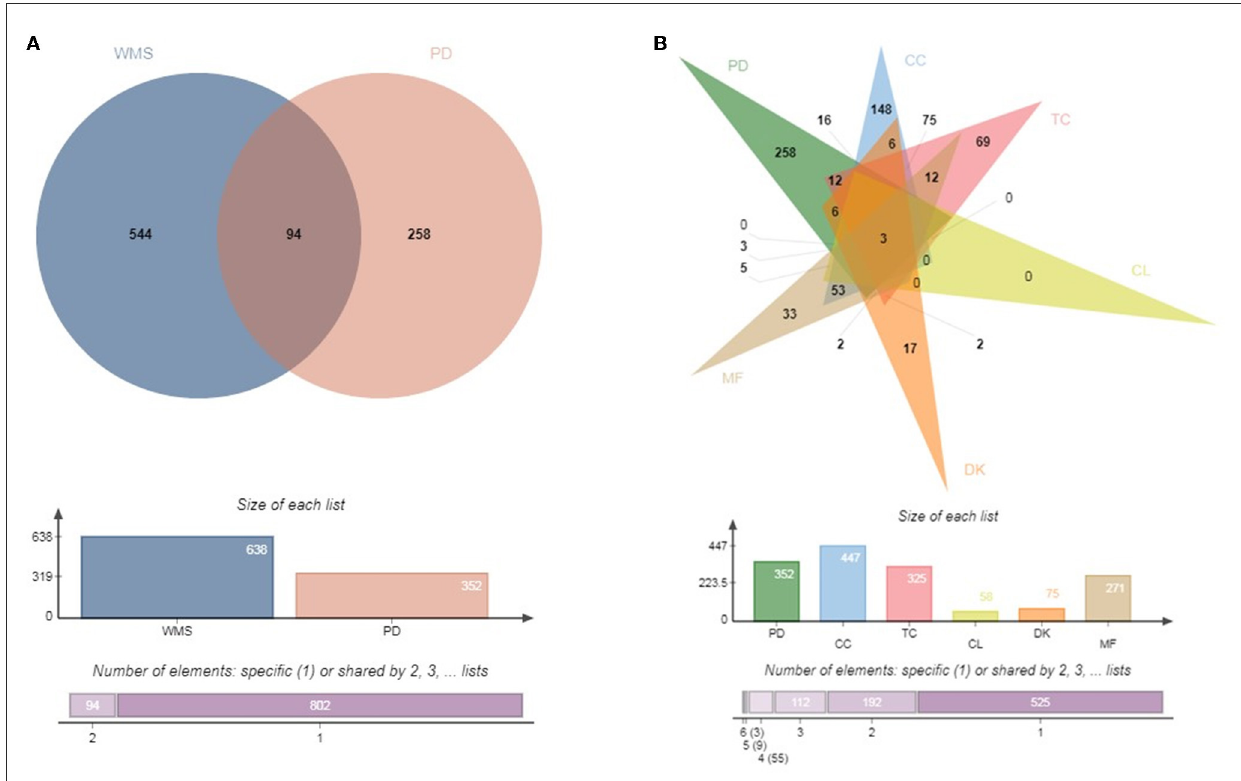
FIGURE2 Venn diagram. (A) Common target genes of WMS and PD. (B) Common target genes of CC, TC, CL, MF, DK, and